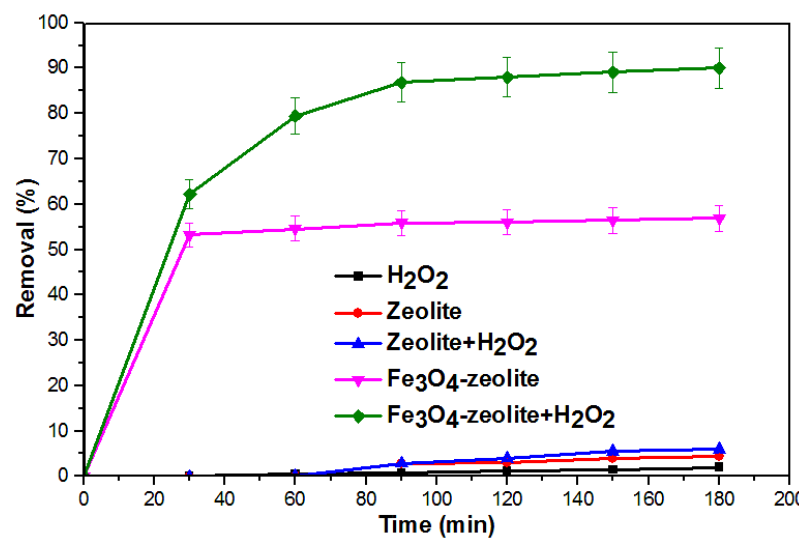
Figure 6. Removal e ffi ciencies of OFL in di ff erent Figure 6. Removal efficiencies of OFL in different processes.